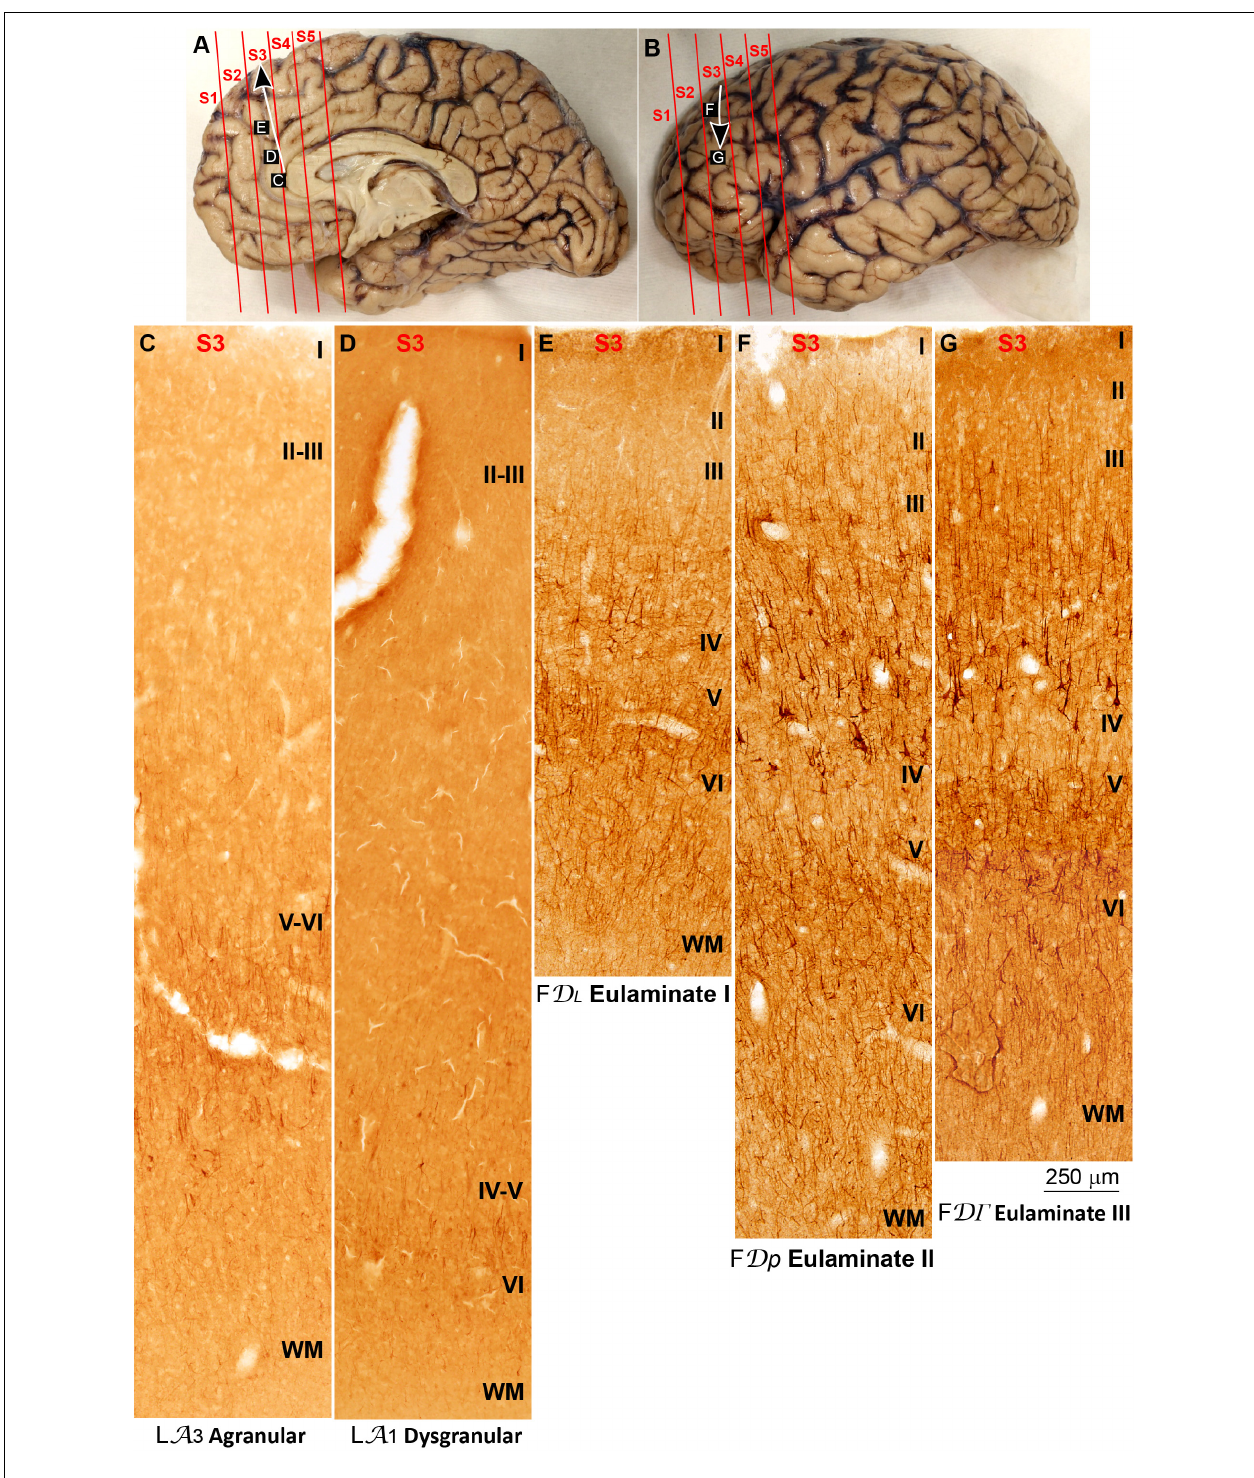
FIGURE 6 | Systematic and gradual variation of laminar structure in SMI-32 immunostained sections across areas of the parahippocampal trend in the human prefrontal cortex. (A,B) Medial (A) and lateral (B) views of the left hemisphere from the brain (case HCD): red lines show the planes of separation of coronal slabs; black and white arrows indicate laminar differentiation along the parahippocampal trend. (C–G) , Micrographs of the anterior cingulate, medial prefrontal, and dorsolateral prefrontal cortices in SMI-32 stained sections at the levels indicated in (A,B) ; the areas according to the Atlas of von Economo and Koskinas (1925/2008) and the cortical type are indicated below each micrograph; see the text for description of laminar features. S1, S2, S3, S4, S5, indicate coronal slabs from anterior to posterior; WM: white matter. Roman numerals indicate cortical layers. Calibration bar in (G) applies to (C–G) .